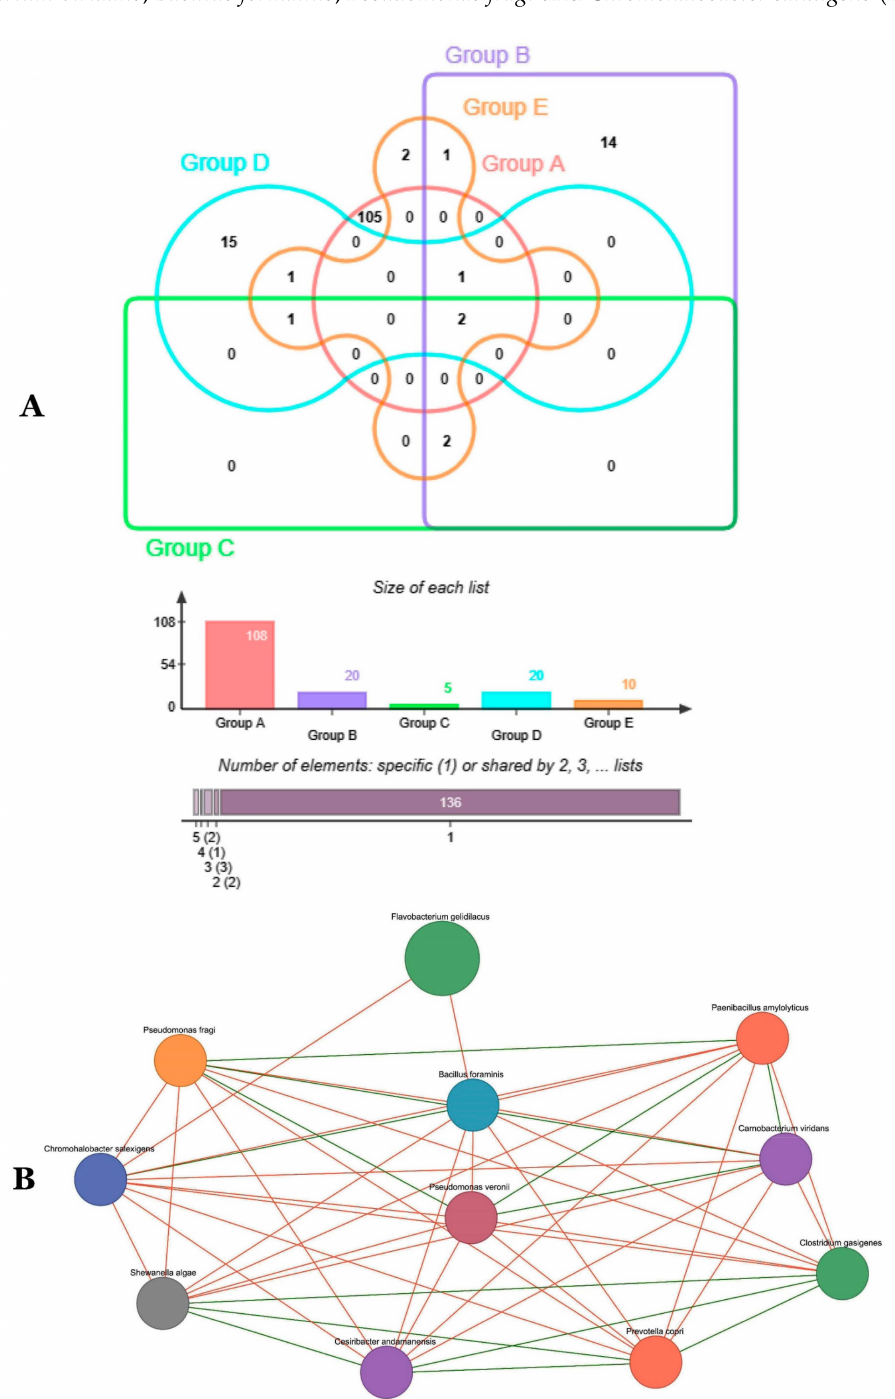
Figure 3. Venn diagram showing overlap between observed OTUs ( A ) and Co-occurrence network of key OTUs ( B ) for PG and plant